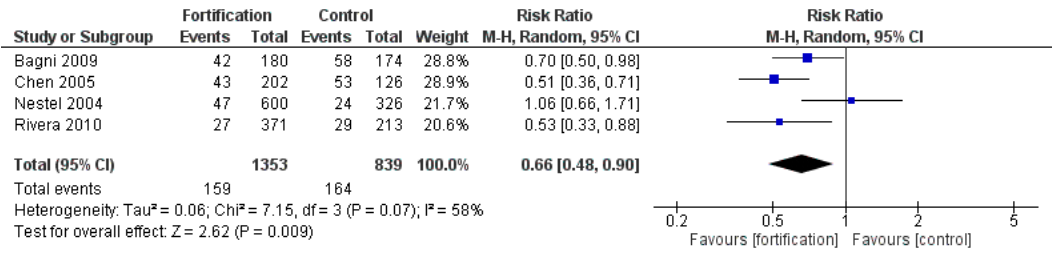
Figure 9. Large-scale food fortification with iron versus placebo/no intervention (efficacy studies) on the risk of anemia (hemoglobin concentration < 110 g/L).